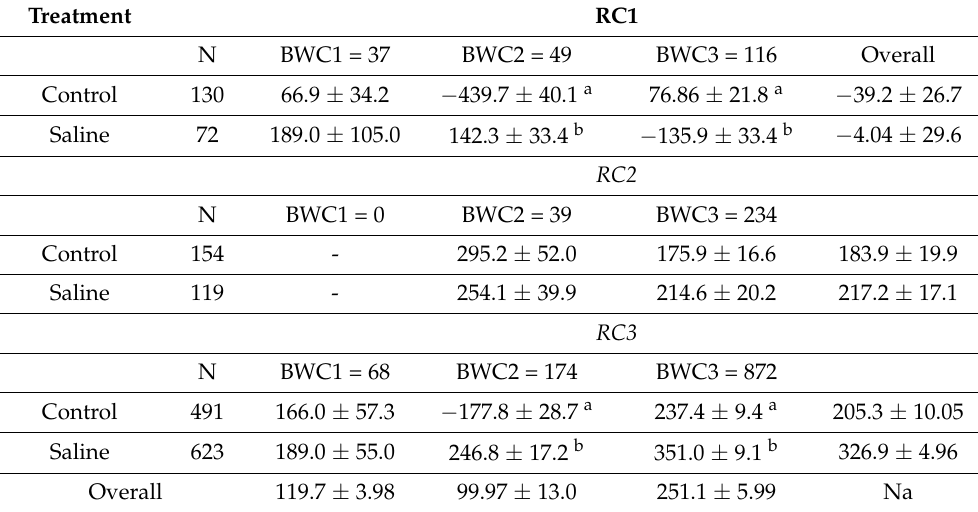
piglet observations per